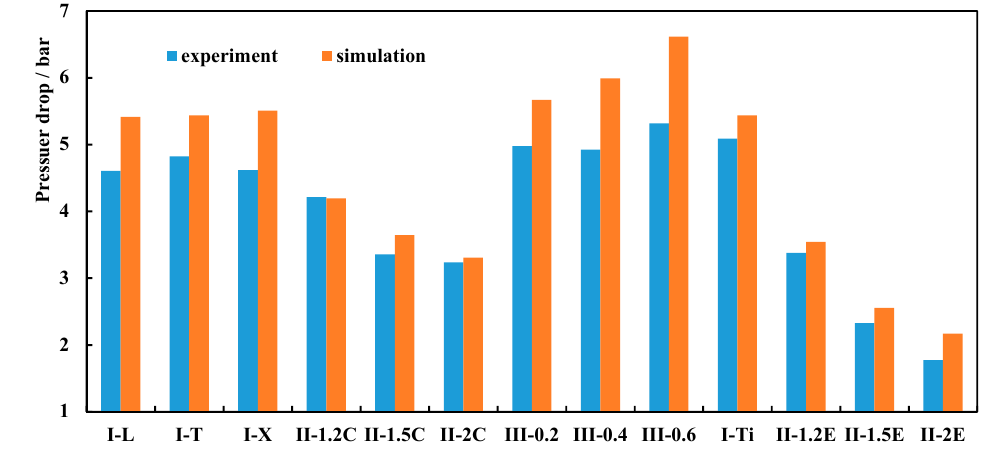
Figure 6. Comparison of experiment and simulation.